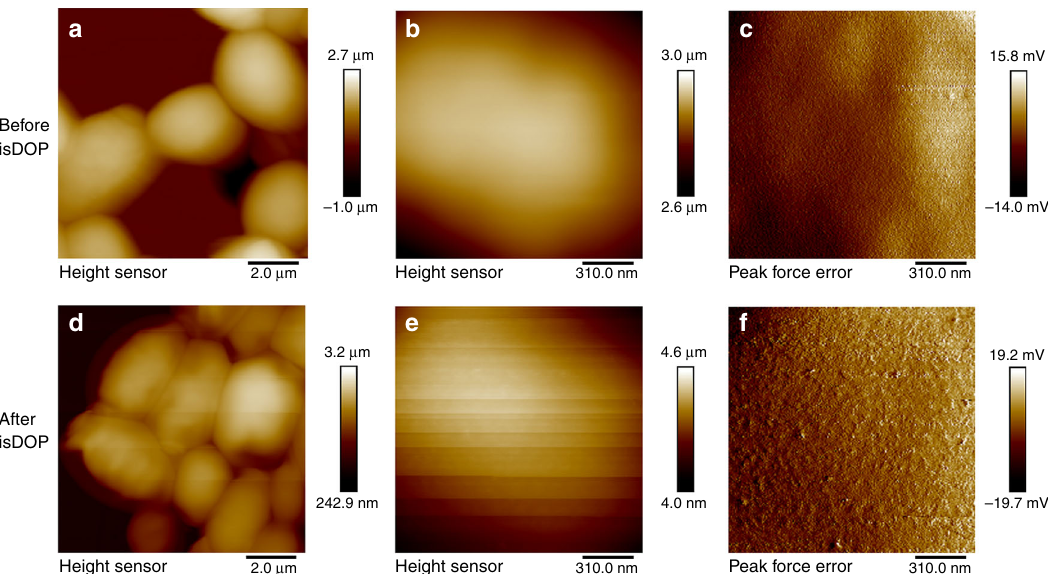
Fig. 4 AFM imaging of the DNA cocoon on cells. a − c The typical AFM images show the surface of yeast cell walls before and, d − f after isDOP. Yeast cells are trapped in polycarbonate porous membrane for AFM imaging in the contact mode. The image scales, 10 μ m × 10 μ m and 2.5 μ m × 2.5 μ m. AFM atomic